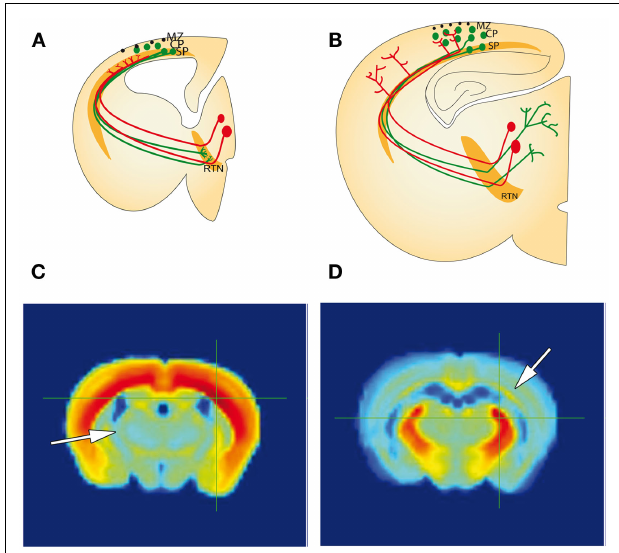
FIGURE 3 | Similarities between the cortical SP zone, and reticular thalamic nucleus during development (A,B), correlated gene expression (C,D). (A) Schematic representation of a forebrain section with the developing corticothalamic connectivity. Corticofugal (green) and thalamocortical (red) axons extend toward each other at early stages during embryonic development and arrive near their targets, but both pause short of their ultimate targets. Corticofugal projections from subplate and layer 6 accumulate in the reticular thalamic nucleus (RTN) and thalamocortical projections accumulate in subplate, respectively. (B) Toward the middle of the first postnatal week corticofugal and corticopetal axons enter the thalamus and cortical plate (CP), respectively, where they arborize and establish their contacts with their ultimate targets in thalamus and neocortex.There are signs of fiber crossings in the RTN and in the subplate indicating some rearrangements during development. ( A and B modified from Montiel et al., 2011). (C,D) Gene correlation heat map from Allan Brain Atlas showing areal gene expression that correlates with expression in the SP (C) and RTN (D) .The crosshairs in each figure show the region sampled for gene expression.These gene correlations show that the SP (arrow in D ) has a higher gene correlation with the RTN than other subpallial structures, and the RTN (arrow in C ) has a higher gene correlation with the SP than other pallial structures.This comparison is in adult, however, and during development the similarities may be even more pronounced. CP, cortical plate; MZ, marginal zone; RTN, reticular thalamic nucleus; SP,